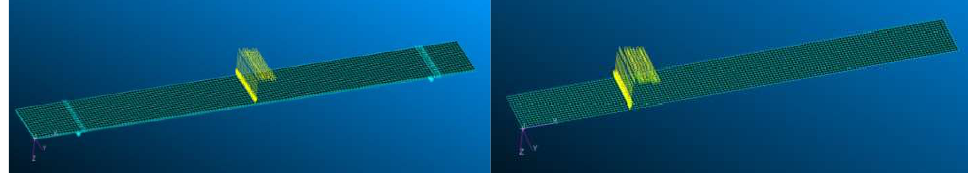
Figure 2. Numerical loads test cases: symmetrical, and non-symmetrical.